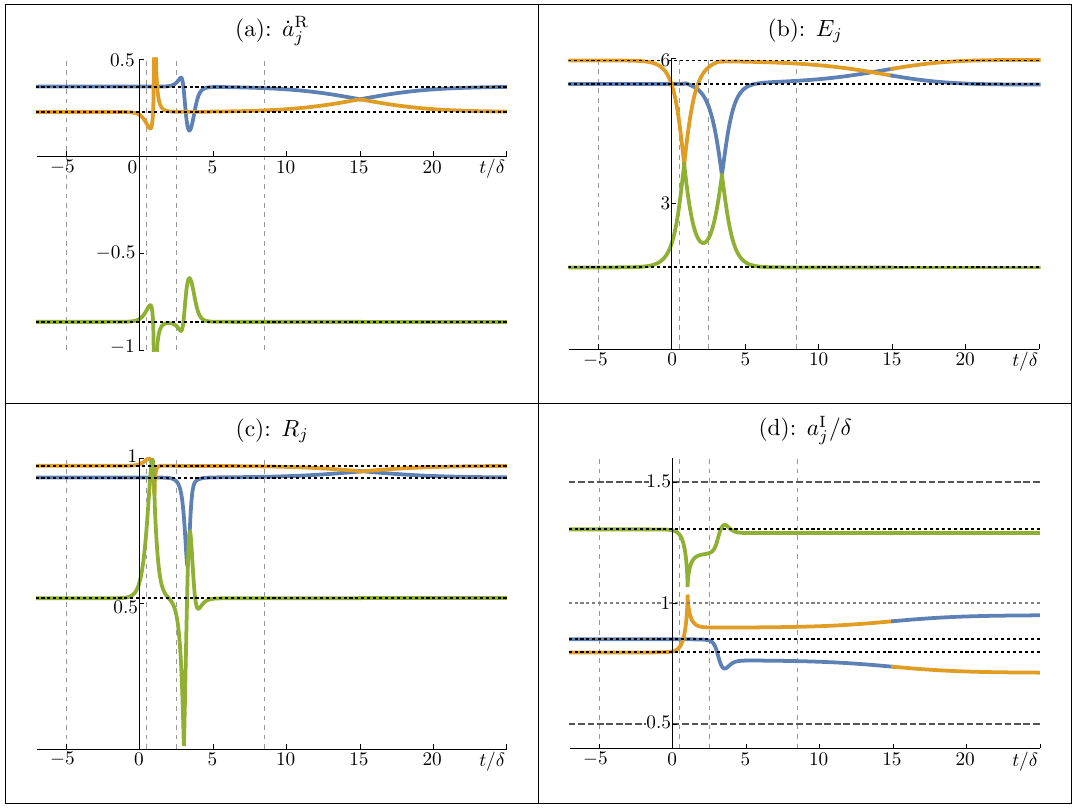
Figure 6 . Time evolution of four important single-soliton quantities for the three-soliton example with the initial data (6.35): (a) velocities ˙ a R ( t ) (6.51), (b) energies E j ( t ) (6.52), (c) radii of rotation j circles R j ( t ) (6.50), (d) imaginary parts of the poles a I ( t ) ( j = 1 , 2 , 3 ). The vertical dashed lines j indicate the times t/δ = 5 , 1 / 2 , 5 / 2 and 17 / 2 when complementary information about this solution − can be found in the figures 3 and 4. The horizontal black dotted lines indicate the constant values in the asymptotic region t . In (d), we also indicate the boundaries and the middle of R + (5.8) δ → −∞ (black dashed horizontal lines and gray dotted horizontal line, respectively). The colors blue, orange, and green correspond to the three different solitons, as in figure